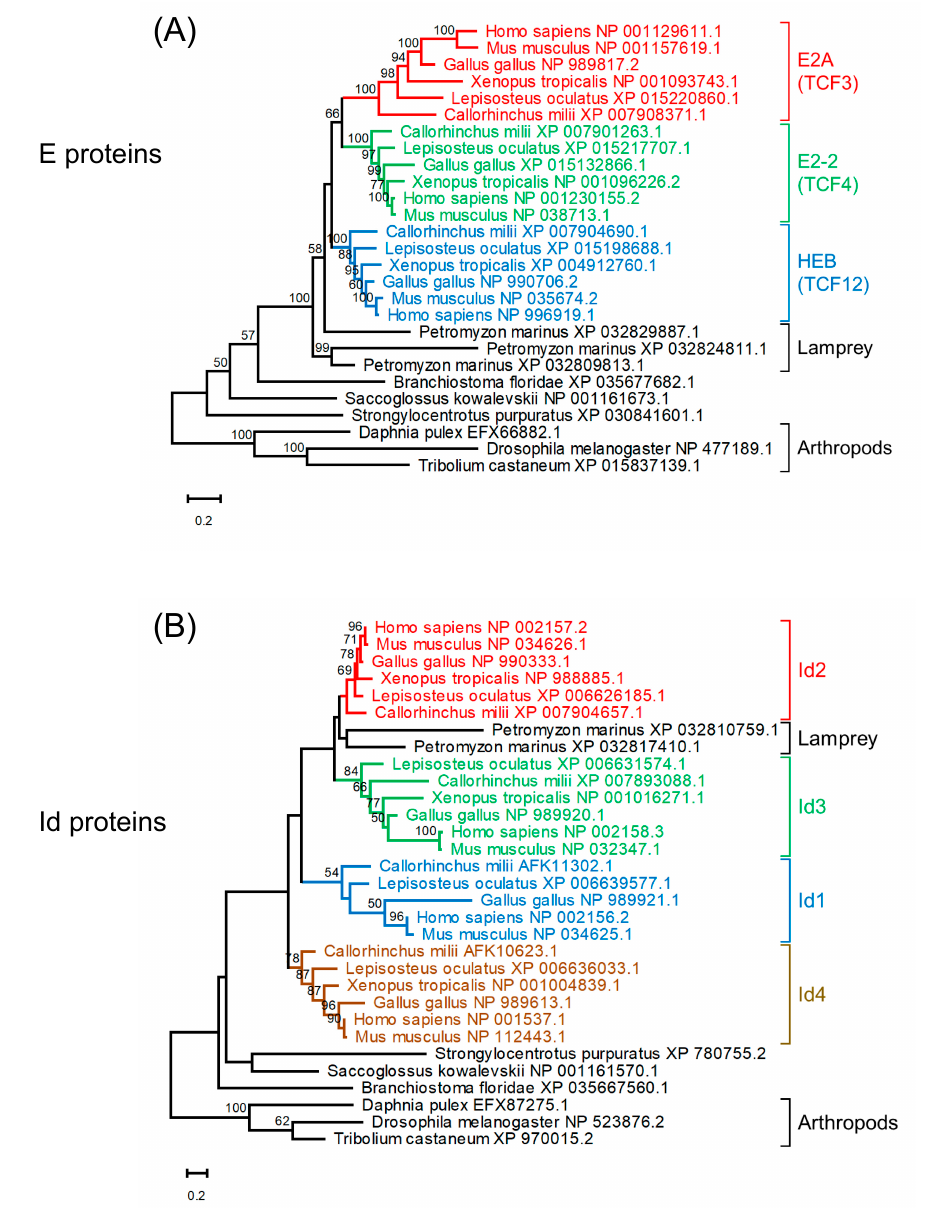
Figure 3. Maximum likelihood phylogenetic trees of homologs of E proteins ( A ) and Id proteins ( B ). Sequences were aligned using MAFFT (v7.453) [68] with default parameters. Tree reconstruction was performed using RAxML (version 8.2.12) [69] with the JTT+F substitution model and PROTGAMMA parameter with 100 bootstrap replicates. Phylogenetic trees were visualized using MEGA-X (version 10.2.4) [70]. Bootstrap values are given along the branches.